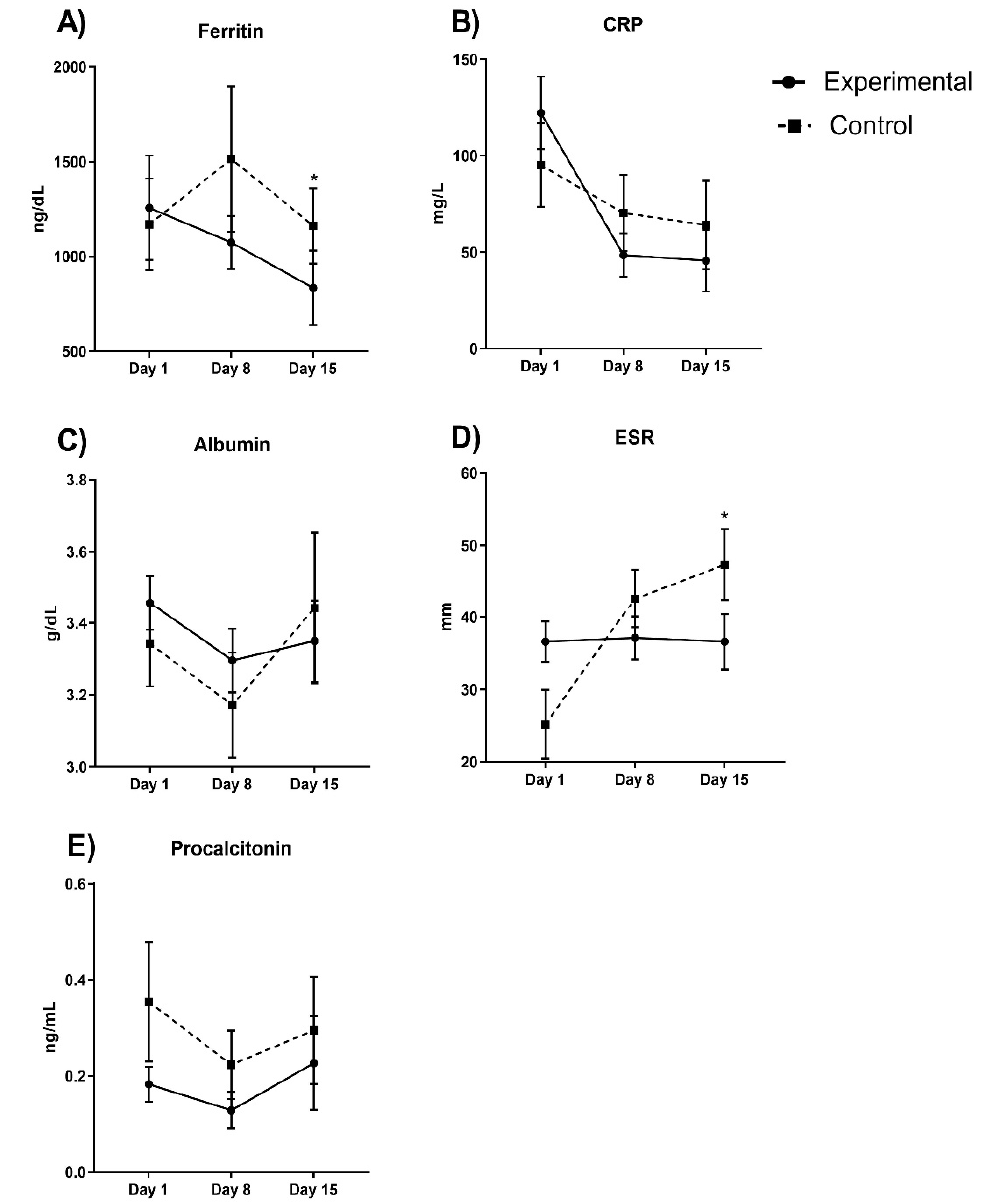
Figure 2. Inflammatory parameters between experimental and control groups evaluated in COVID-19 patients. Ferritin diminishes in the experimental group approximately by 50% ( p = 0.001). In ( A ) we observe ferritin values; ( B ) CRP levels; in ( C ) albumin; ( D ) ESR and ( E ) procalcitonin during hospital stay days comparing both experimental vs. control group. Auto-controlled analysis did not show significant changes in the experimental in ESR ( p > 0.05), but in the control group, it significantly increased ( p = 0.0001). Considering a covariate adjustment, experimental group ESR was significantly decreased in comparison with the control group ( p = 0.01). CRP and procalcitonin did not significantly decrease in the experimental group (74% and 33%, respectively; p > 0.05 in both). * p < 0.05. Figure 3 shows the blood count parameters; hemoglobin and hematocrit decreased in experimental group by 5.6 and 9.7%, respectively, but these differences were not signif- icant ( p > 0.05 in both). Cellular counting showed that erythrocyte and neutrophils did not